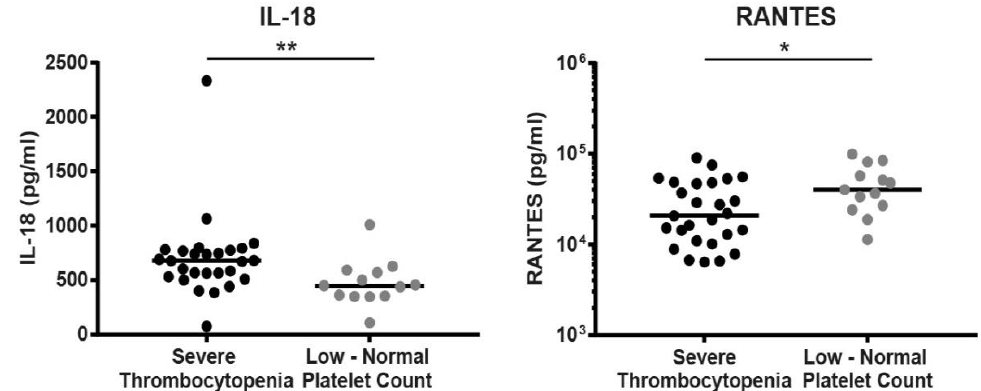
Figure 1. Serum markers correlated with severe thrombocytopenia in PUUV patients. Patients were considered to display significant thrombocytopenia when platelet counts were <100 × 10 9 /L. Statistical significance was calculated by the Mann–Whitney U test; *, indicating a p -value < 0.05, and **, indicating a p -value < 0.01, were considered statistically significant. Abbreviations: IL-18, interleukin-18. Table 3. Overview of serum marker levels in PUUV patients. Patients were considered to display severe thrombocytopenia when platelet levels were <100 × 10 9 /L. Statistical significance was calculated by the Mann–Whitney U test; p -values < 0.05 were considered statistically significant. Median (range). Abbreviations: ICAM-1, intercellular adhesion molecule 1; IL-6, interleukin-6; IL-8, interleukin-8; PAI-1, plasminogen activator inhibitor-1; PSGL-1, P-selectin glycoprotein ligand-1; sCD40L, soluble CD40 ligand; tPA, tissue plasminogen activator; uPAR, urokinase plasminogen ac- tivator surface receptor; VEGF, vascular endothelial growth factor; Galectin-3BP, galectin-3 binding protein; IGFBP-7, insulin-like growth factor-binding protein 7; IL-18, interleukin-18; IP-10, inter- feron gamma-induced protein 10; KIM-1, kidney injury molecule-1; NGAL, neutrophil gelatinase- associated lipocalin; TFF3, trefoil factor 3.